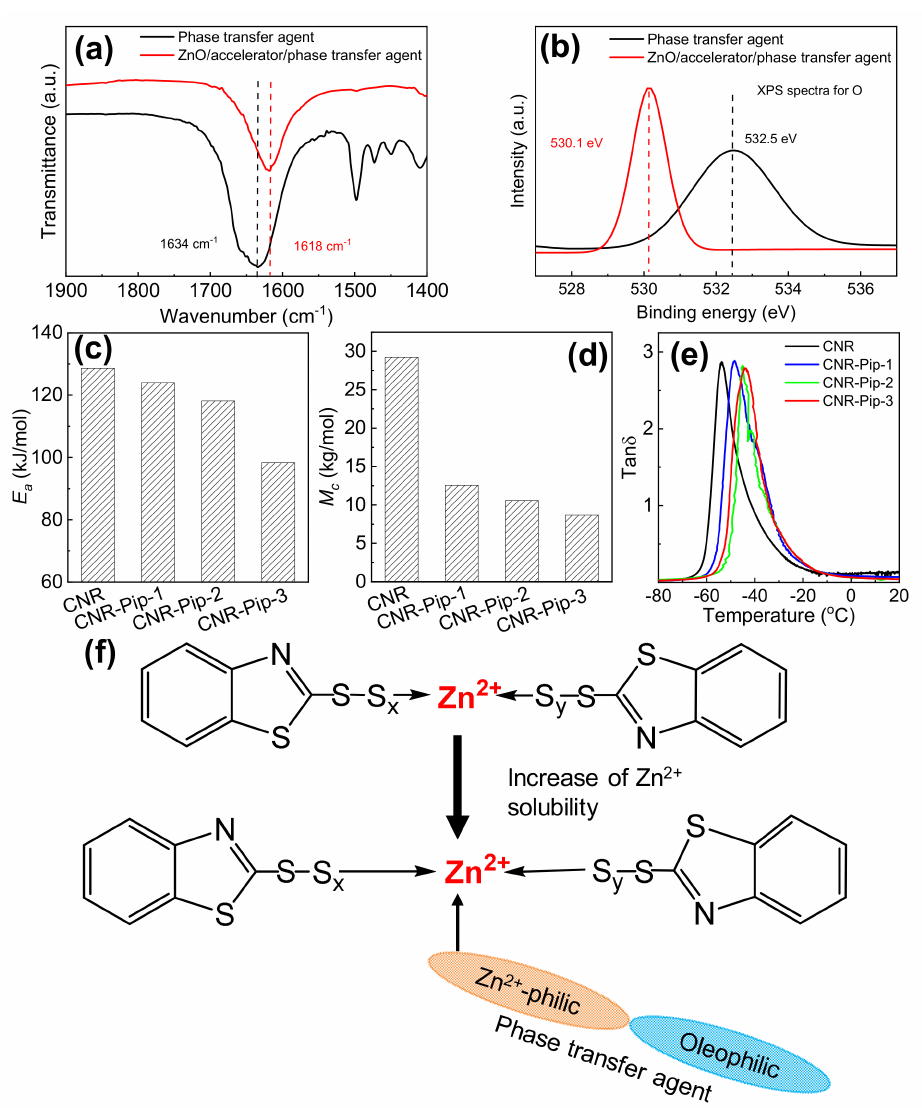
Figure 3. Changes in crosslinking structure after the addition of phase transfer agent. ( a ) FTIR spectra of phase transfer agent and ZnO/accelerator/phase transfer agent. ( b ) XPS spectra of phase transfer agent and ZnO/accelerator/phase transfer agent. ( c ) E a of CNR, CNR-Pip-1, CNR-Pip-2, and CNR-Pip-3. ( d ) M c of CNR, CNR-Pip-1, CNR-Pip-2, and CNR-Pip-3. ( e ) Temperature dependence of tan δ curves for CNR, CNR-Pip-1, CNR-Pip-2, and CNR-Pip-3. ( f ) Schematic illustration of Zn 2+ solubility increase in the matrix by phase transfer